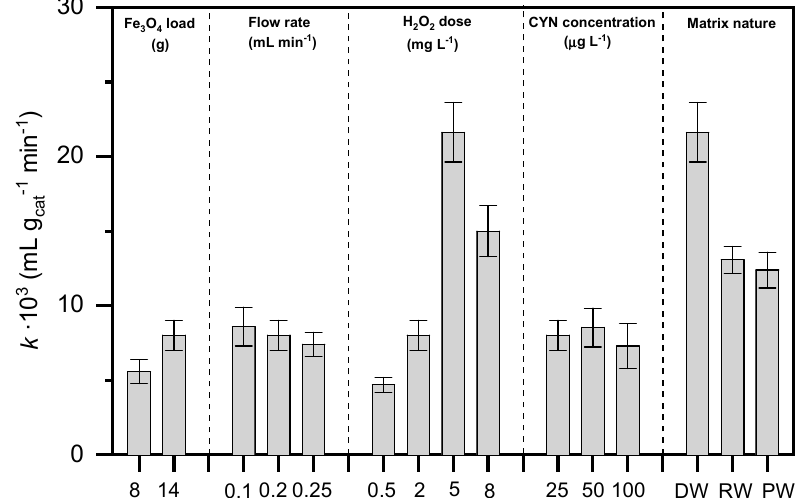
Figure 2. Apparent pseudo-first order kinetic constants obtained in the CWPO of CYN at di ff erent operating conditions (standard conditions: flow rate = 0.2 mL min − 1 , [CYN] 0 = 25 µ g L − 1 , [H 2 O 2 ] 0 = 2 mg L − 1 , W Fe3O4 = 14 g, pH 0 = 5; T = 25 ◦ C). The abbreviations DW, RW and PW stand for deionized water, river water and pond water, respectively.